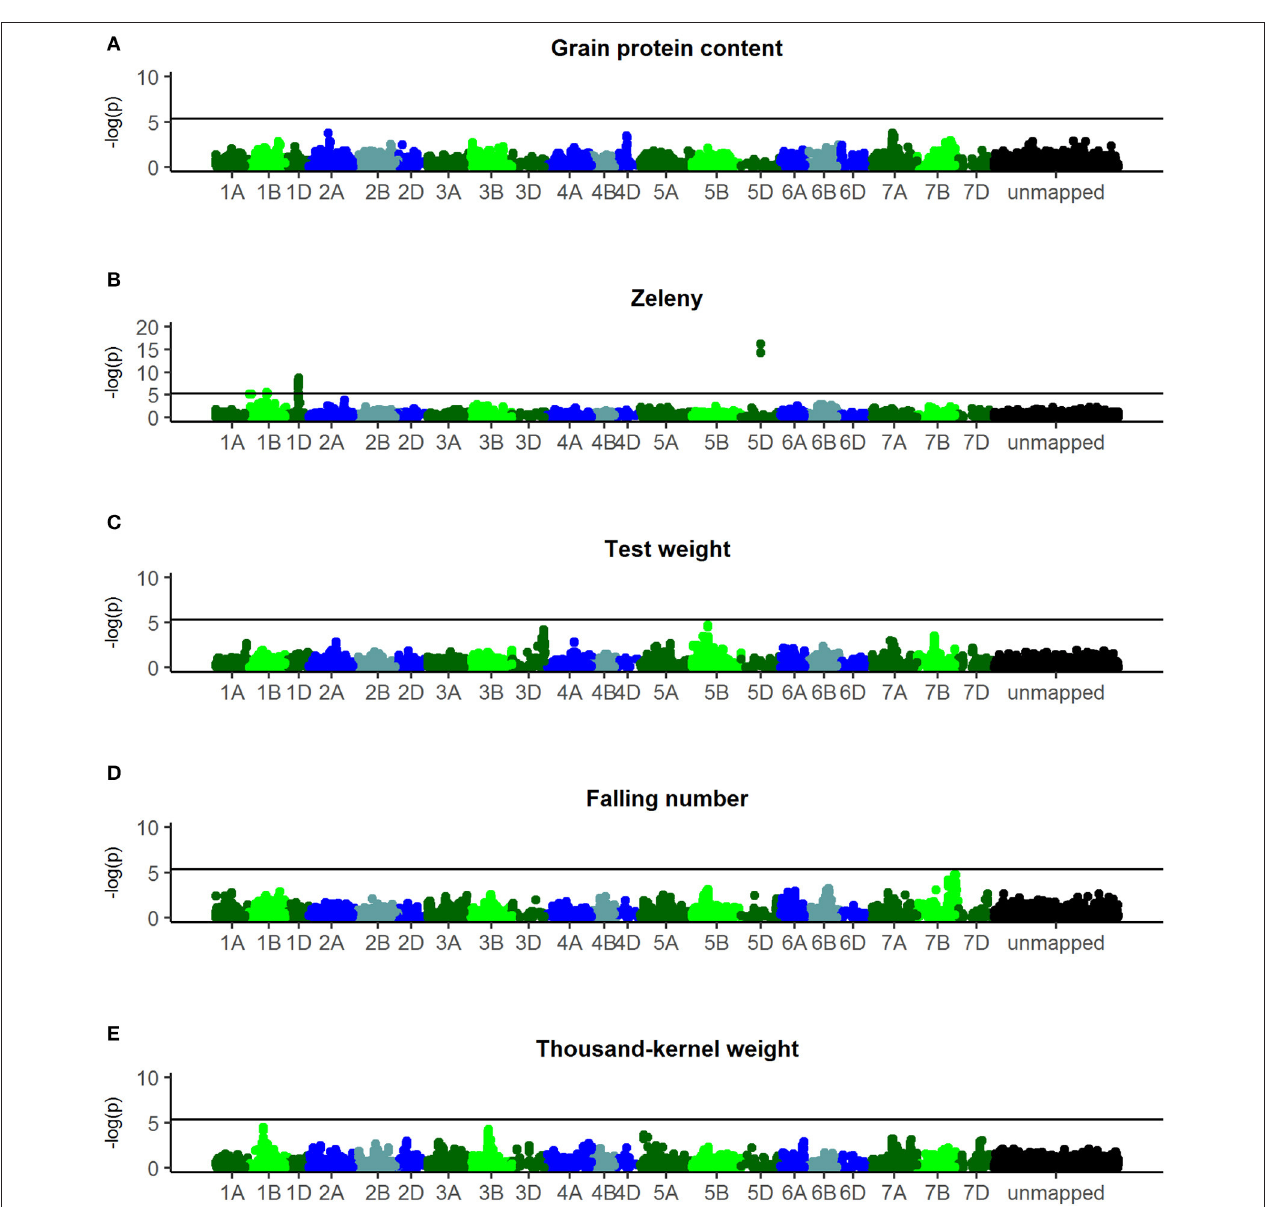
FIGURE 5 | Manhattanplots of –log 10 ( p -values). (A) Grain protein content, (B) Zeleny, (C) test weight, (D) falling number, (E) thousand-kernel weight. Last bin is unmapped SNPs.